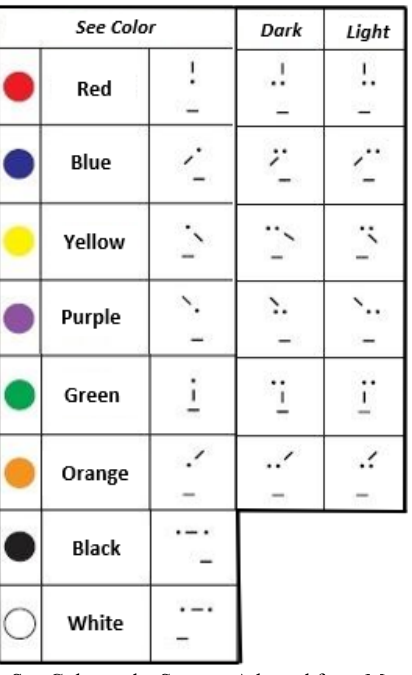
Figure 7. See Color code. Source: Adapted from Marchi, 2019